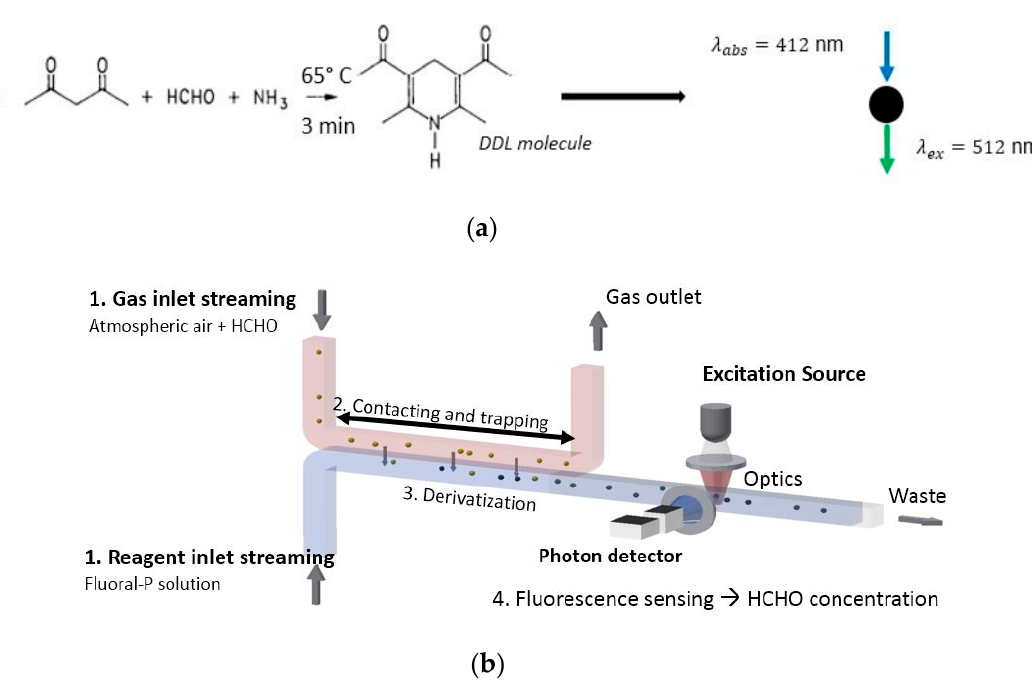
Figure 1. Formaldehyde (HCHO) detection methodology. ( a ) Chemical derivatization reaction of formaldehyde into 3,5–diacetyl-1,4-dihydrolutidine (DDL). ( b ) Gas–liquid contacting, trapping, and detection scheme.